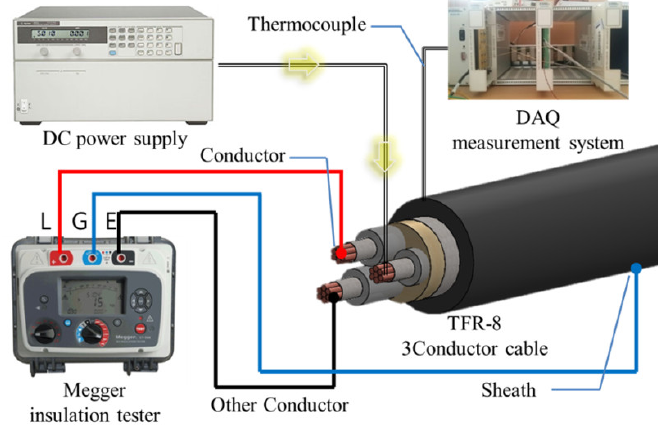
Figure 7. Experimental setup under the over-current condition.